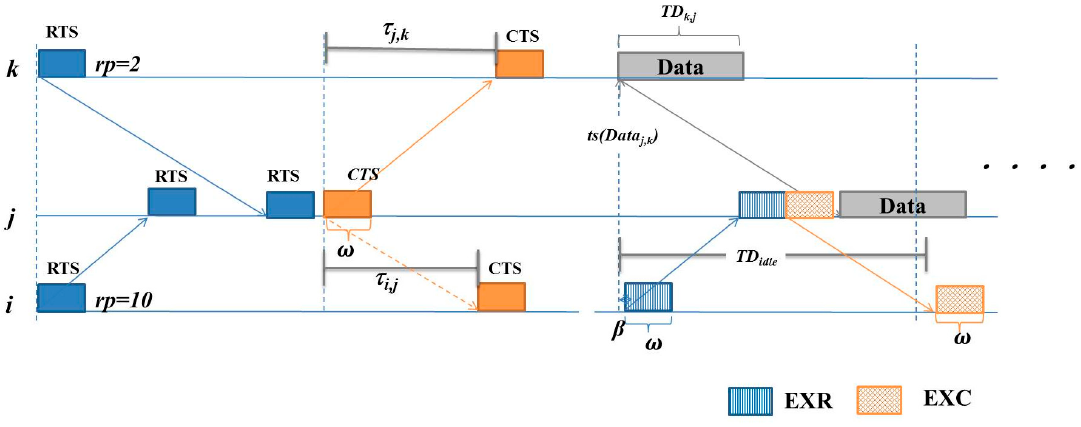
Figure 4. Sensor i asking an extra communicating chance to sensor j .